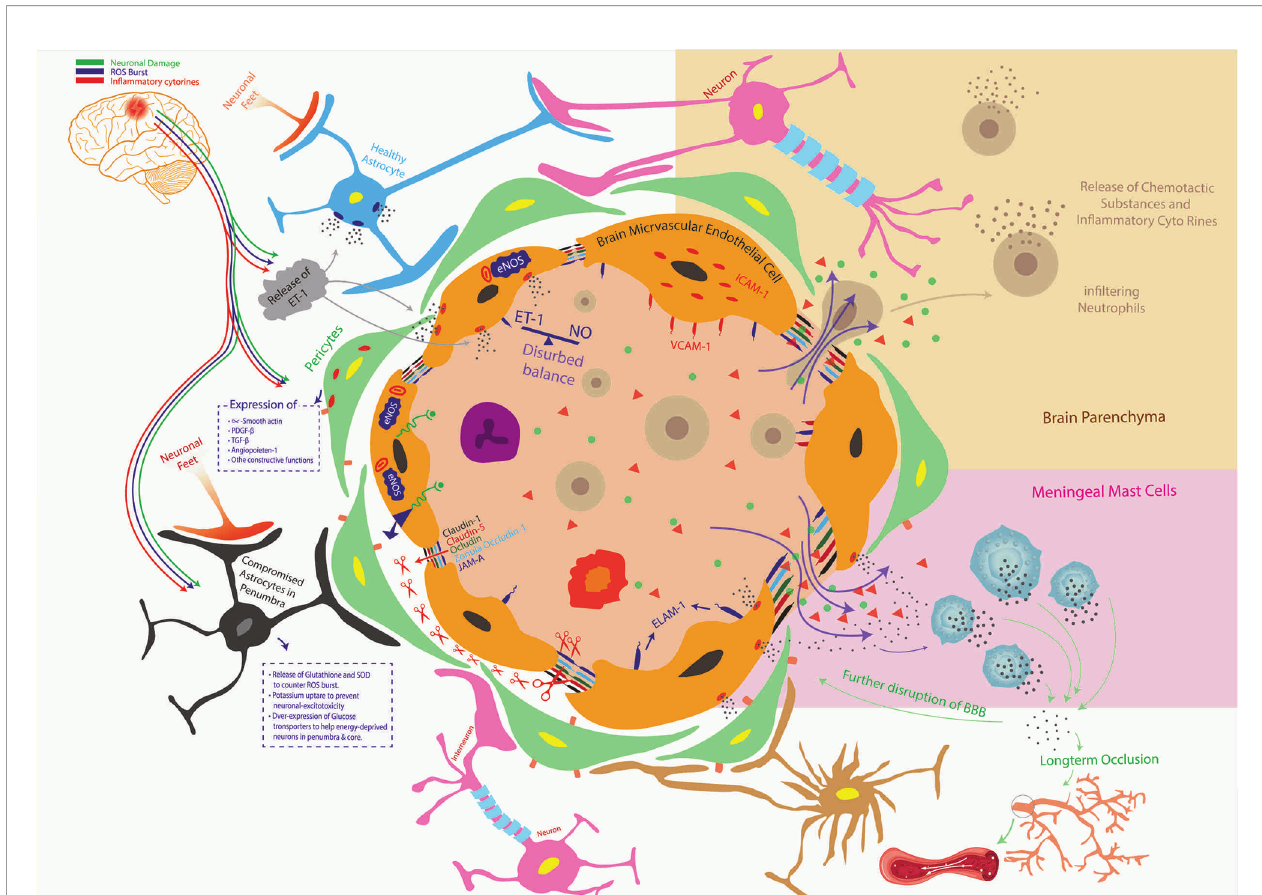
FIGURE 7 | Ischemic stroke and orderly compromisation of BBB. The brain microvascular endothelial cells (BMECs), Astrocytes, Pericytes, and Microglial cells make BBB. Compromised BBB integrity is the striking preliminary feature of the neuroin fl ammatory-triangle during the hypoxic pathophysiological state, where astrocytes in penumbra, pericytes, and BMECs start releasing ET-1 (disturbed balance of ET-1 and NO). This leads to the upsurge in the expression of a variety of adhesion molecules in/on BMECs such as ICAM-1, VCAM-1, and ELAM-1 to facilitate trans-endothelial migration of leukocytes. ET-1 also upregulates the expression and release of matrix metalloproteinases (MMP) from BMECs which lyse inter-endothelial connecting proteins such as Claudin 1, Claudin 5, Ocludin, Zona ocludin-1, junctional adhesion molecule-A (JAM-A), and others. This compromises the barrier ’ s integrity, otherwise tightly maintained by BMECs, thus allowing the release of in fl ammatory cytokines, in fi ltration of systemic immune cells, and fl uid escape (brain edema). In fl ammatory cytokines stimulate meningeal Mast Cells to release more in fl ammatory mediators to further the BBB shattering and causing long-term occlusion of blood to already starved brain tissue. Along with BMECs, the functionally compromised Pericytes and Astrocytes in penumbra put their respective neurodegenerative part (crossed red-mark in dotted boxes). The population of in fi ltrating immune cells and their pro-in fl ammatory secretions proceeds a vicious neuroin fl ammatory circle that only aggravates brain edema and infarct